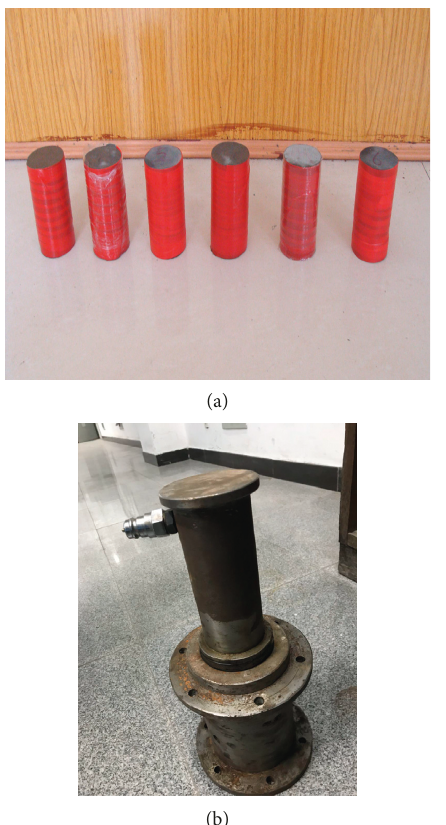
Figure 4: (a) Rock samples and (b) the experimental apparatus.